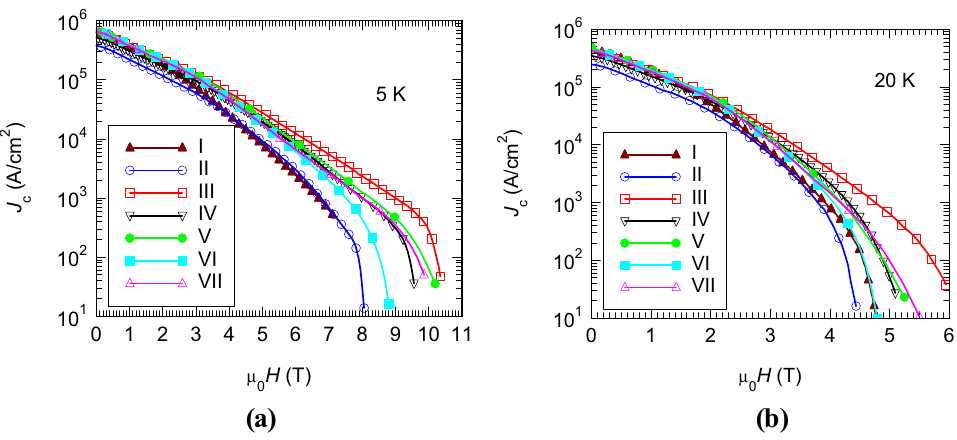
Figure 5. Critical current density versus applied magnetic field for samples I–VII at: ( a ) 5 K and ( b ) 20